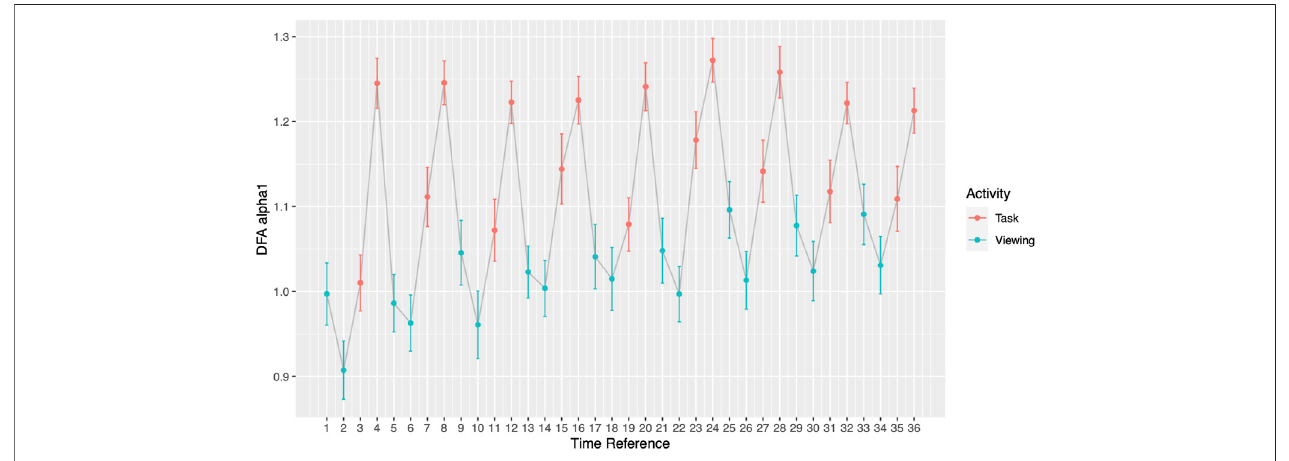
FIGURE 4 | DFA α 1 by segments at one-minute scale. Grey line connects activities chronologically.